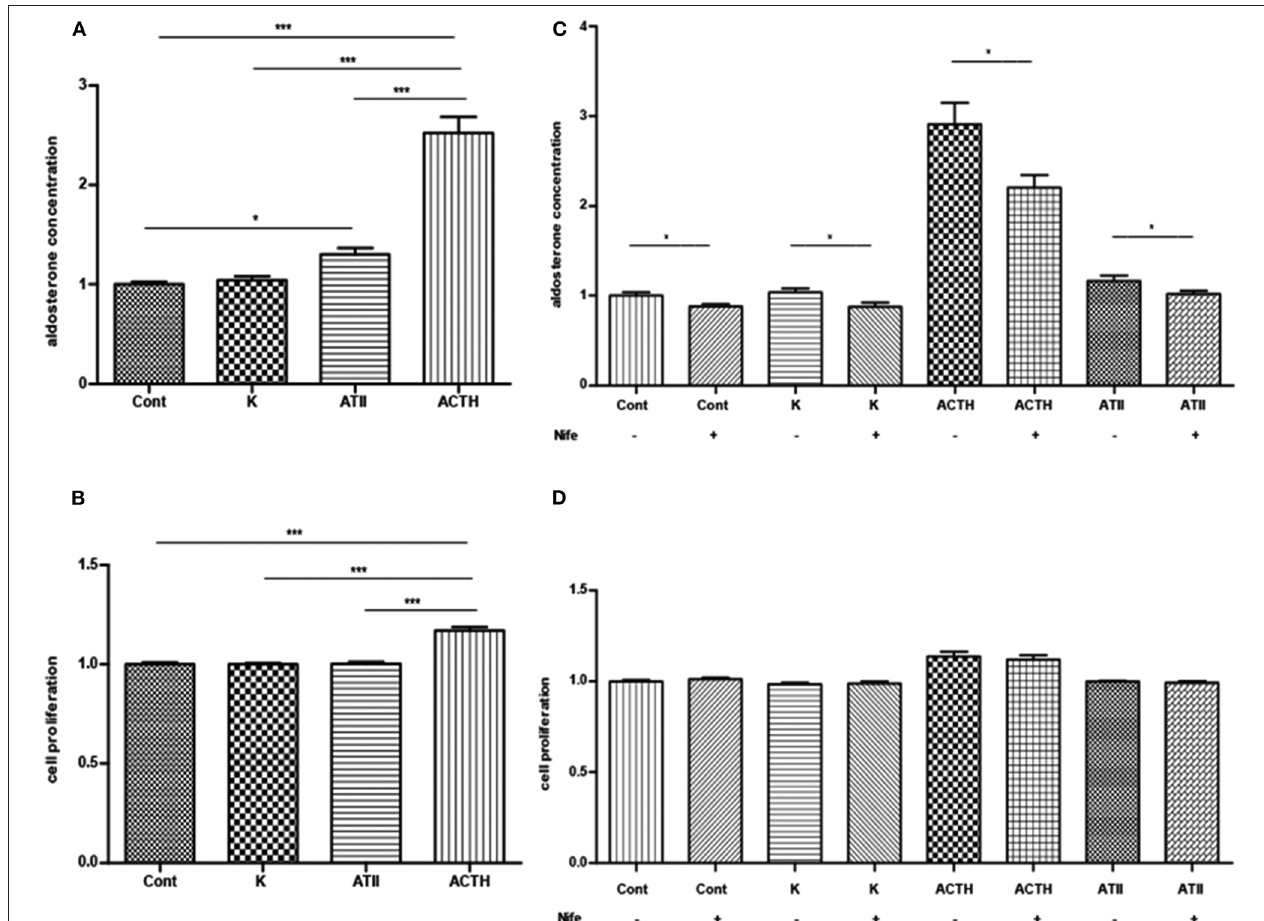
FIGURE 3 | (A,B) Effects of ACTH, ATII and potassium on aldosterone secretion ( A , mean ± SE, N = 7) and cell proliferation ( B , mean ± SD, N = 6). (C) Effects of nifedipine on basal or ACTH-, ATII- and potassium-induced aldosterone secretion (mean ± SE, N = 4). (D) Effects of nifedipine on basal and ACTH-, ATII- and potassium-induced cell proliferation (mean ± SD, N = 4). Control, ACTH, ATII and potassium group were only compared with its corresponding group treated with nifedipine in (C,D) ; Cont, control; K, potassium, a final concentration of 15 µ M; ATII, angiotensin II, a final concentration of 100nM; ACTH: a final concentration of 100nM * P < 0.05; *** P <